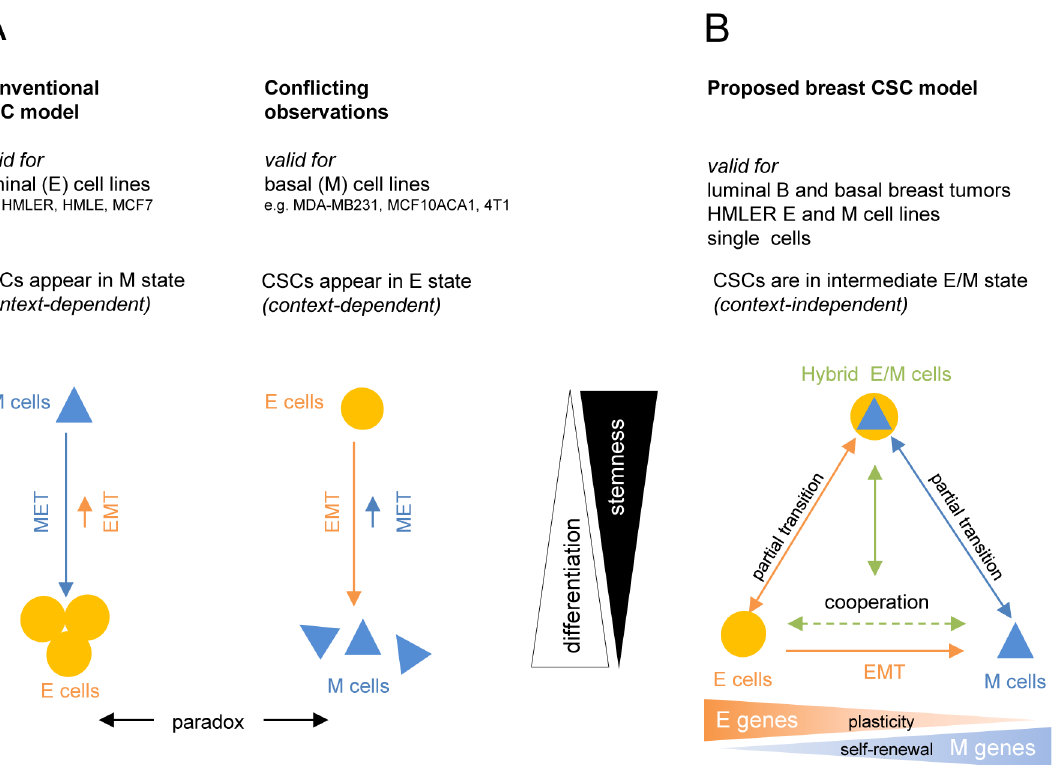
Fig 6. The conventional versus a new integrative CSC model for breast cancer. (A) In luminal epithelial cell-lines (e.g. in HMLE, HMLER, MCF7) the conventional model describes breast CSCs as M cells and ‘ non cancer stem cells ’ as E cells. Paradoxically, in more basal mesenchymal cancer cell-lines (MDA-MB231 cells, MCF10ACA1, 4T1) the more E gene-expressing cells are associated with CSC-properties. Thus, the identity of CSCs appears to be context-dependent. (B) Our model for CSCs integrates and explains these paradoxes by the existence of stem-like intermediate hybrid E/M cells independent of the tumor cell line. We propose that compared to more ‘ polarized ’ differentiated E (capable of plasticity) and M cell-types (capable of self- renewal), undifferentiated hybrid E/M cells can generate more mammospheres and heterogeneous progeny due to their capacity of both, self-renewal and plasticity. Arrows indicate possible state transitions (incomplete EMT and MET) between the instable hybrid E/M state and the extreme stable E and M states. Stemness of the intermediate E/M state is reflected both by presence of stem-like hybrid E/M cells and by co-presence of E and M cell-types due to cooperation. Context-independency of the stemness of the intermediate E/M state explains the paradoxical context-dependent meaning of E genes in basal tumors and M cell lines and stemness of M genes in luminal B tumors and E cell-lines (A).